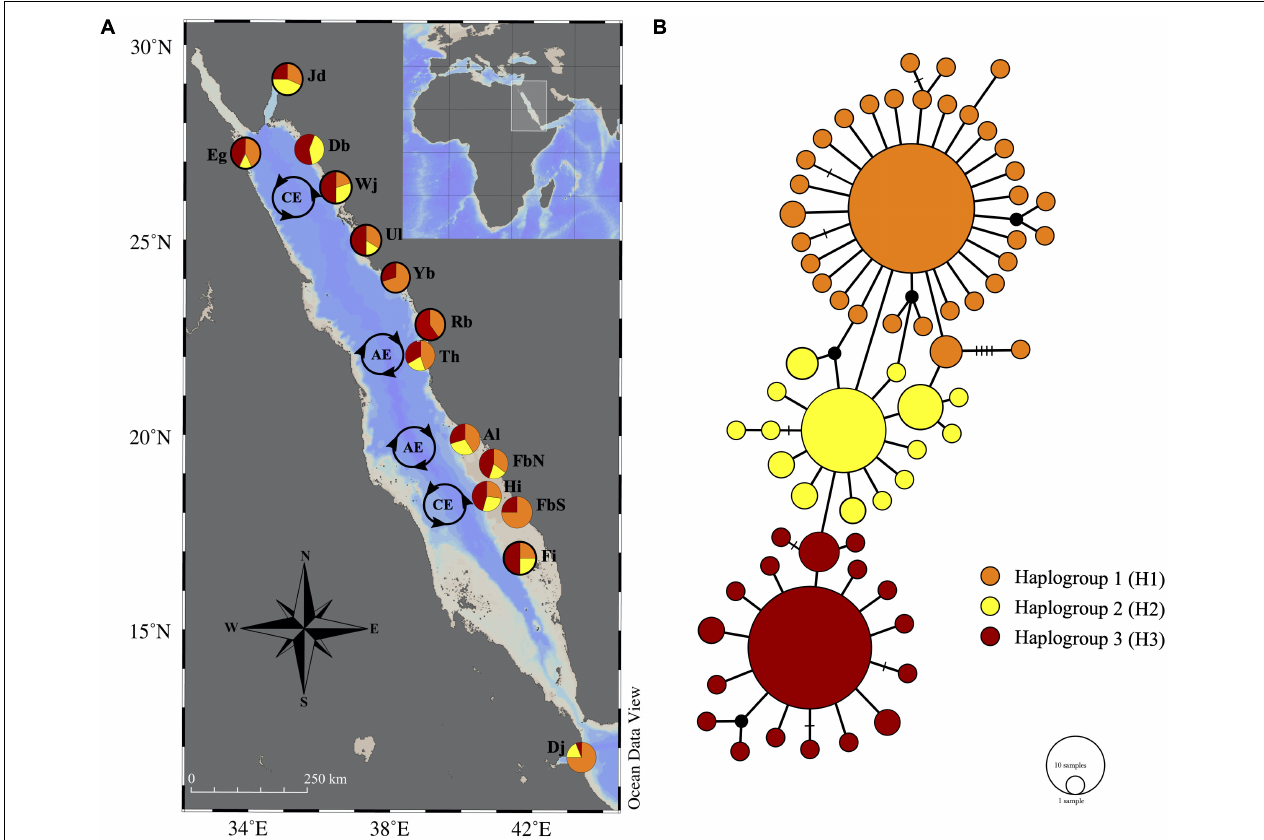
FIGURE 2 | (A) Locations of Tridacna maxima populations sampled in the Red Sea. Pie charts represent the proportion of the haplogroups (see network) per site. Pie charts with black outline were from previous studies. For abbreviations of sample sites, see Table 1 . (B) TCS network of 67 mitochondrial cytochrome (c) oxidase I haplotypes from 194 individuals. Each circle corresponds to one haplotype, the size of the circle is proportional to its frequency. Connecting lines between circles represent one mutational step and the hatches indicate additional mutational steps. The small black circles are missing intermediate haplotypes.